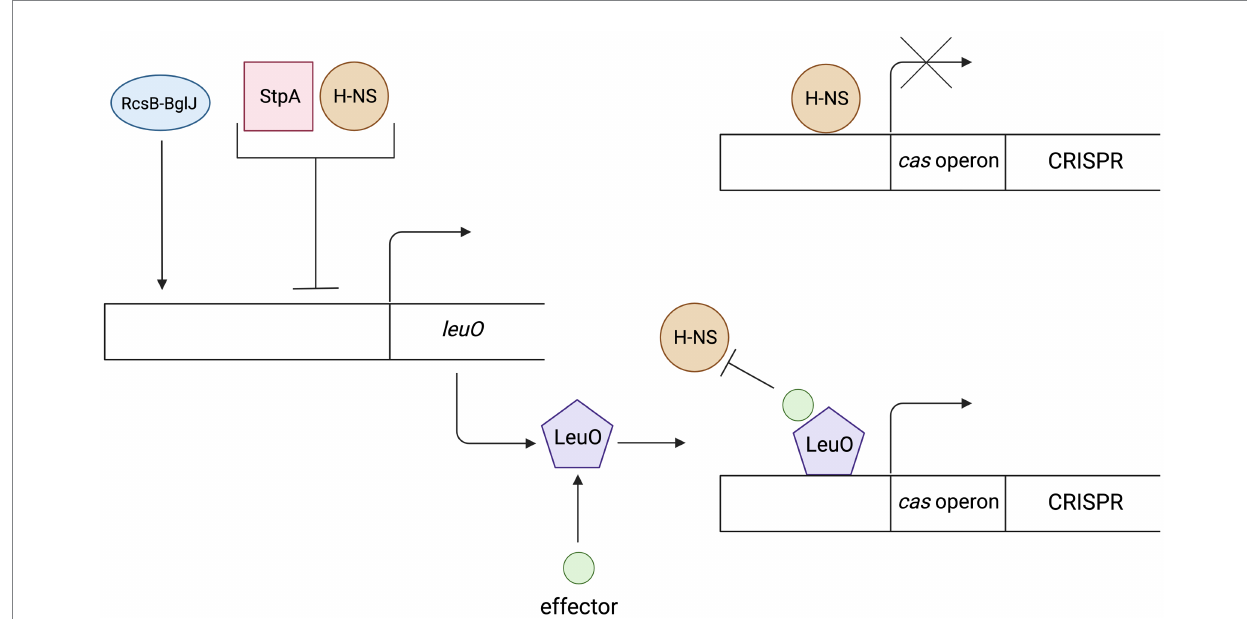
FIGURE 2 The mechanism of regulation and action of the LeuO protein. Expression of the LeuO proteins is inhibited by the H-NS, StpA proteins and by the LeuO protein (after reaching a high level in a cell). Expression is activated via the RcsB-BglJ heterodimer. The LeuO protein requires a specific signal (effector) to counteract H-NS-mediated repression of cas gene transcription. Created with